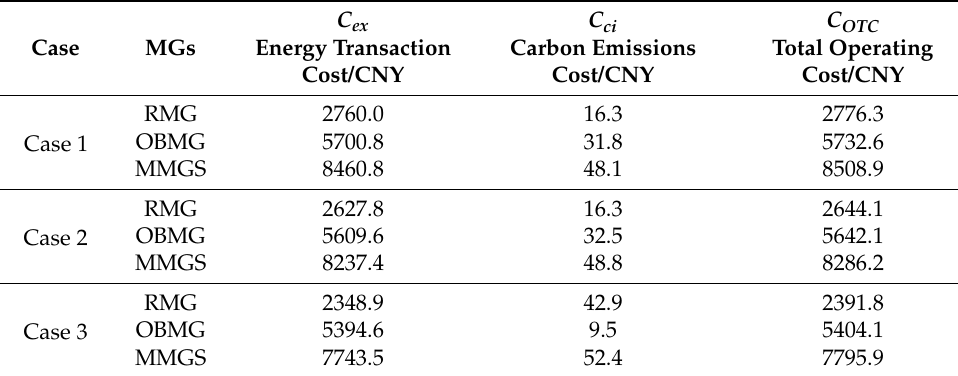
Table 2. Comparison of operating cost in three cases.